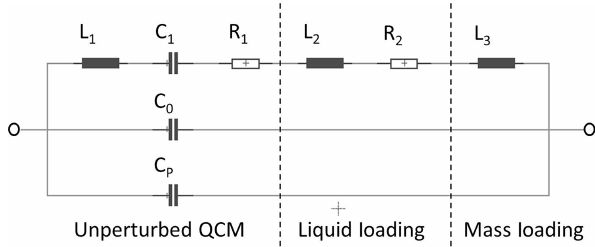
Figure 1. Modified Butterworth–van Dyke circuit after Martin et al.